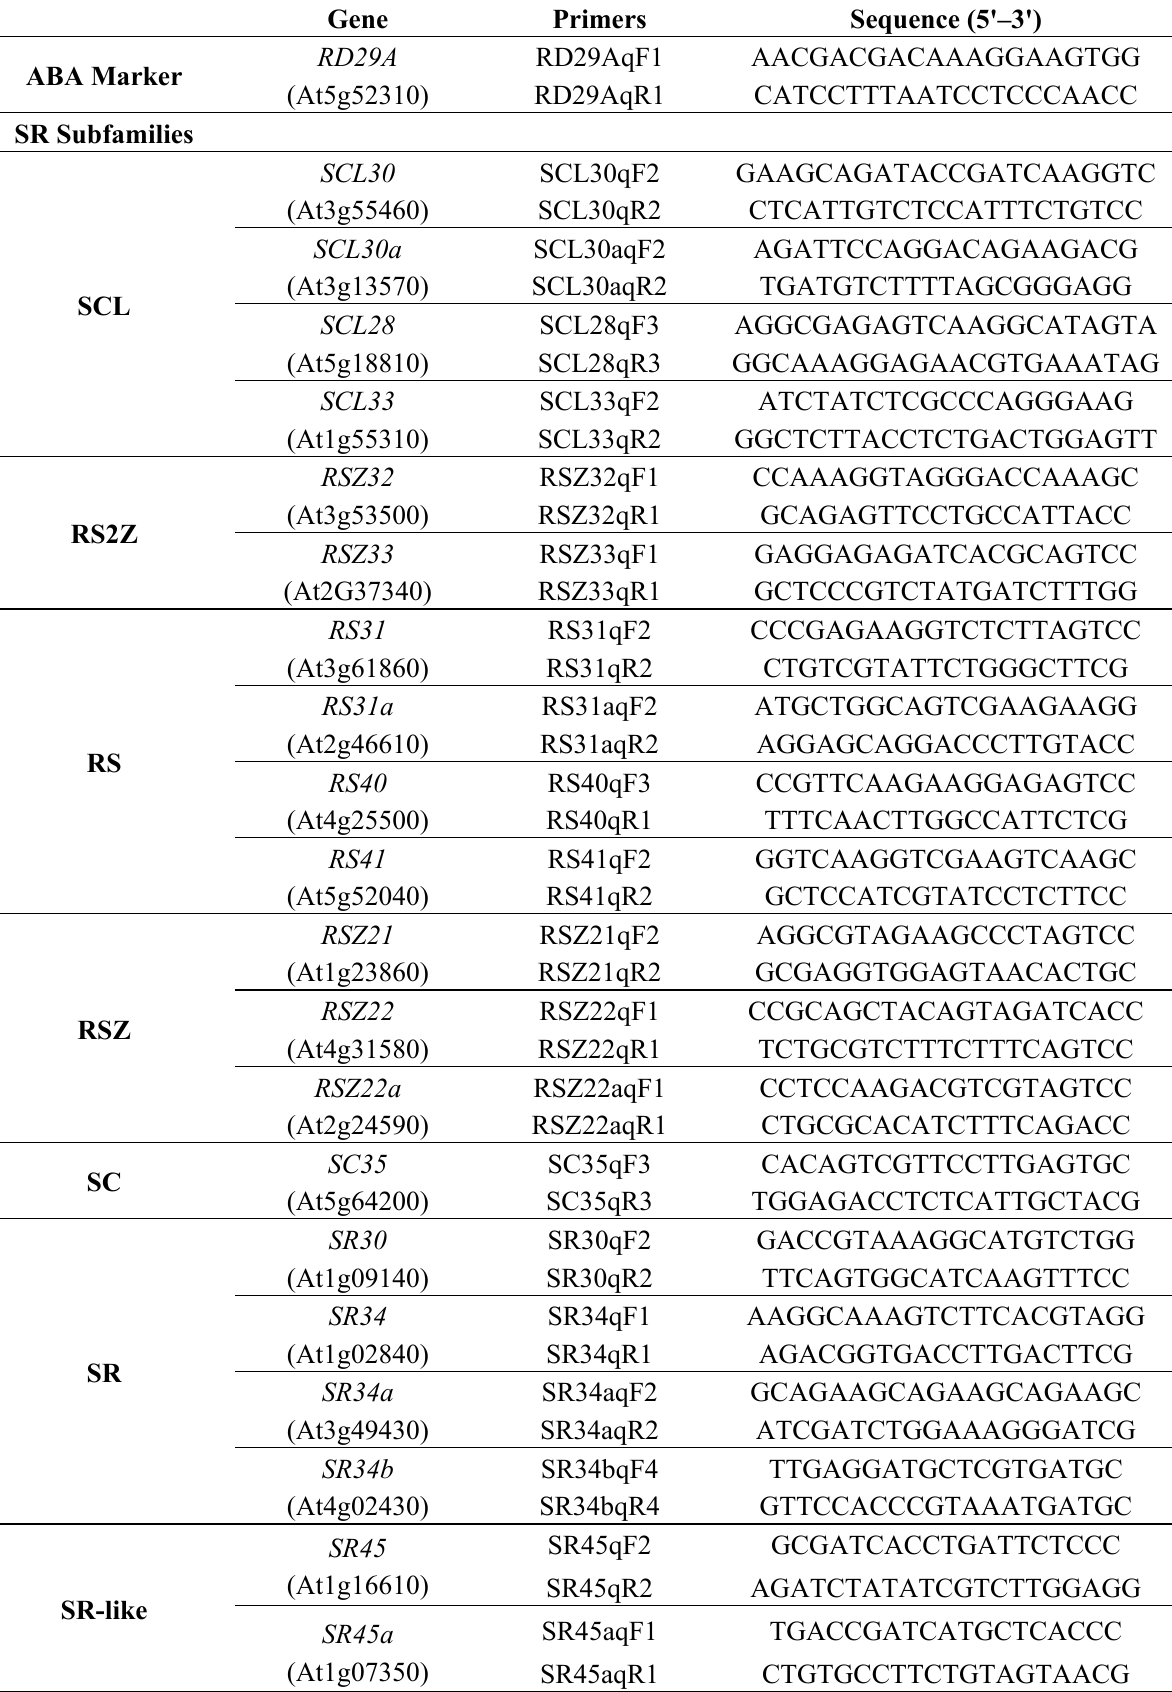
Table 2. Sequence of the primers used in the RT-qPCR analyses. Gene Primers Sequence